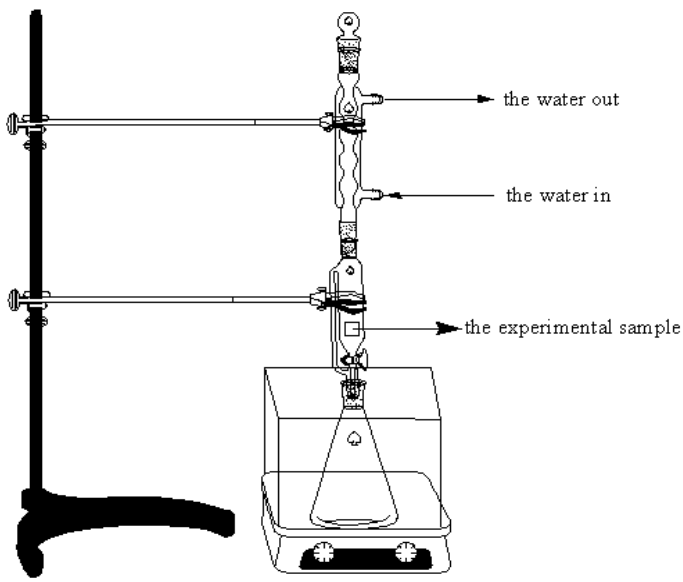
Figure 3. Chemical diagram of the extraction experiment.